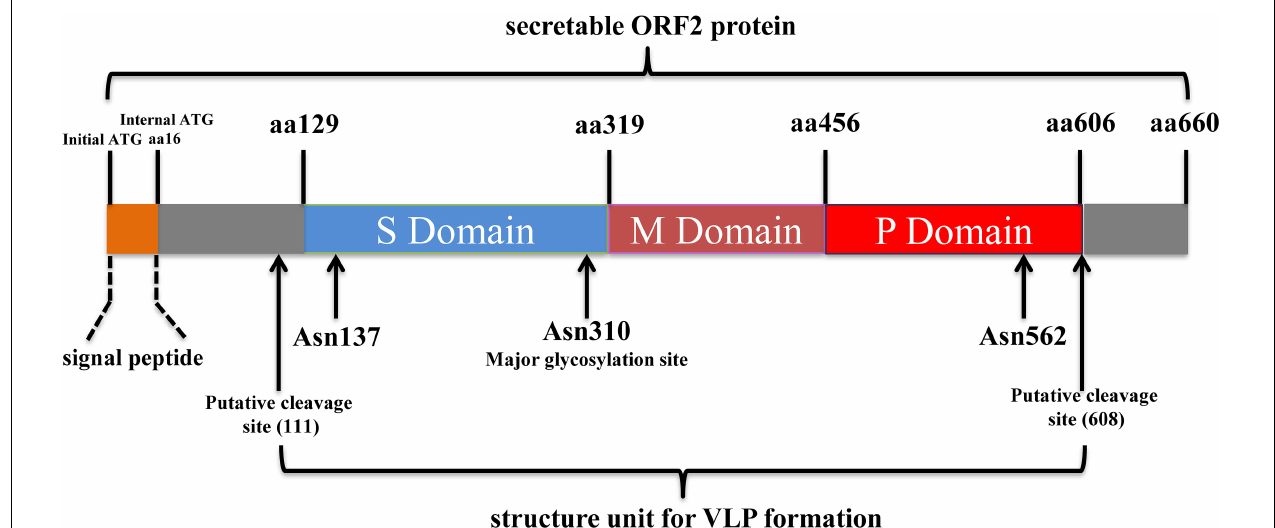
FIGURE 2 | Schematic illustration of structure and functional domains of HEV-ORF2 protein. The capsid protein has three domains designated as Shell (S), Middle (M), and Protruding (P) domain. The S domain is responsible for forming the T = 1 icosahedral shell of virion which contains 60 copies of capsid protein. The M domain binds tightly to the S domain and interacts with two 3-fold-related M domains to form a surface plateau. The P domains are tightly associated as a dimeric spike which is responsible for binding with susceptible